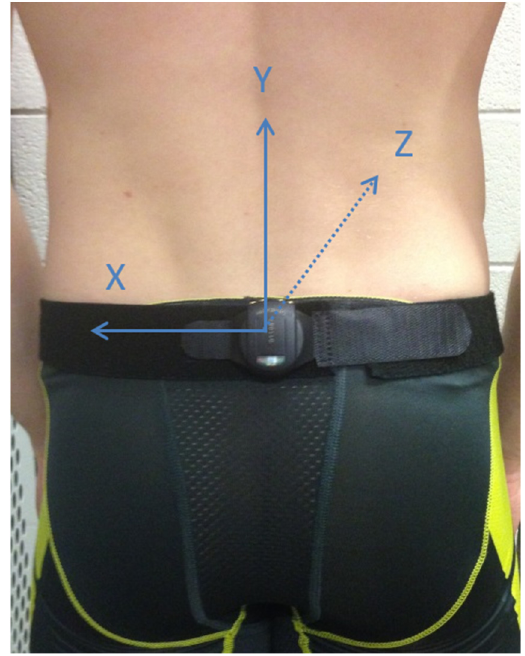
Figure 1. Image showing s ensor orientation, placement and alignment.